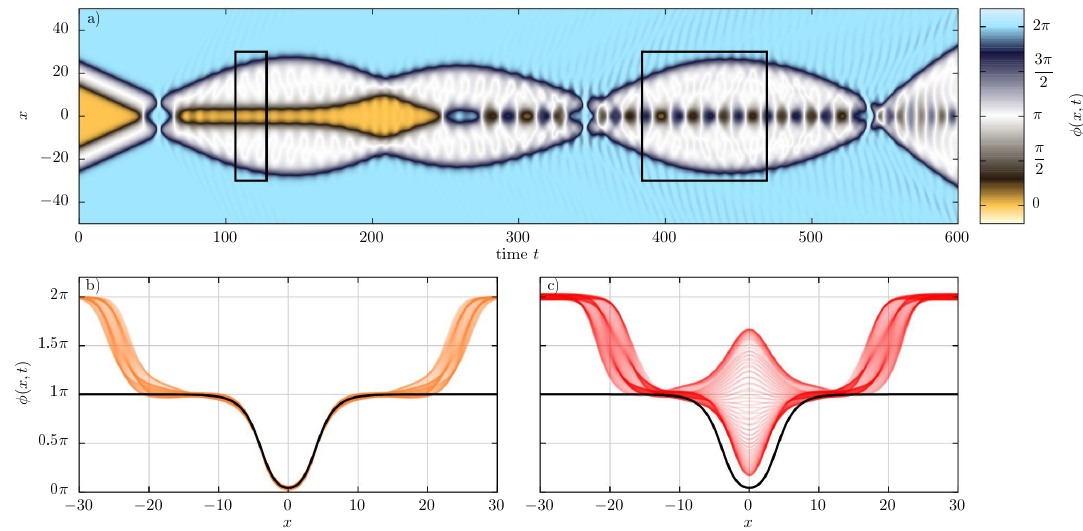
Figure 28 . A further collision process, comparing the profiles of an intermediate state (b) and a bion (c) to the unstable lump solution (black line), for (cid:15) = 2 . 59935 ( β = 3 . 09887 ) and v = 0 . 31